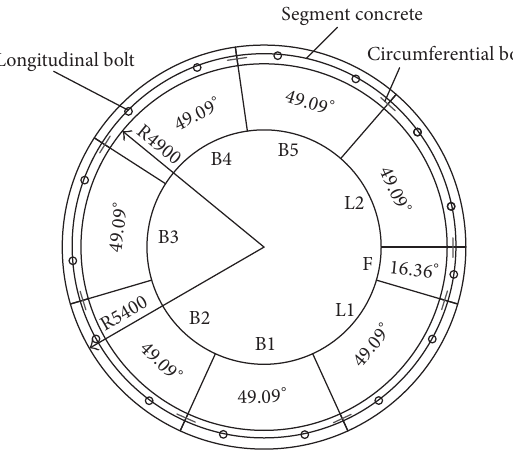
Figure 1: The cross section of the investigated tunnel